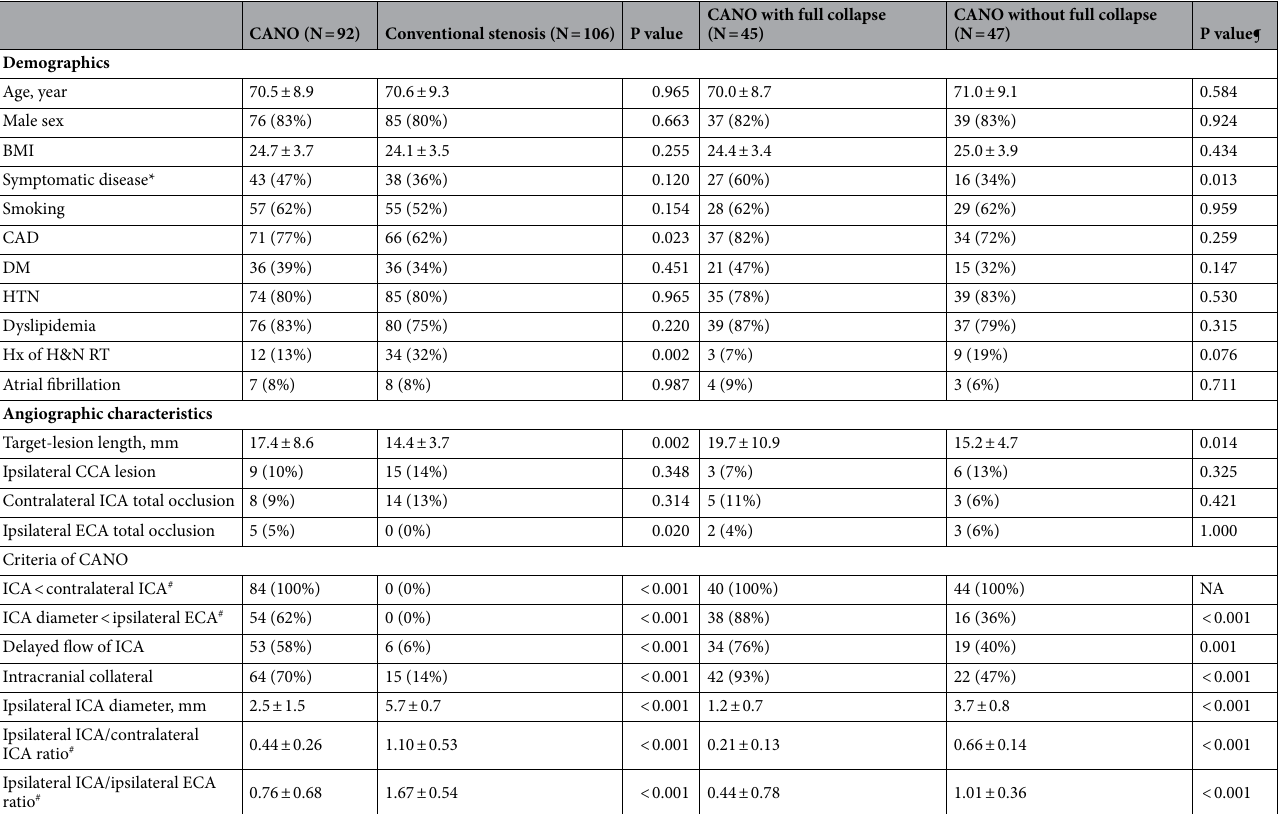
Table 1. Demographics and angiographic data. BMI: body mass index; CAD: coronary artery disease; DM: diabetes mellitus; HTN: hypertension; Hx: history; CVA: cerebral vascular accident; H&N RT: head and neck radial therapy; CCA: common carotid artery; TICI: the thrombolysis in cerebral infarction; ICA: internal carotid artery; ECA: external carotid artery. *Symptomatic disease: a hemispheric transient ischemic attack (distinct focal neurologic dysfunction) or monocular blindness persisting less than 24 h or a stroke with persistence of symptoms or signs for more than 24 h within the previous 120 days before the index procedure. analysis. ¶ P value of comparing CANO patients with and without full collapse.